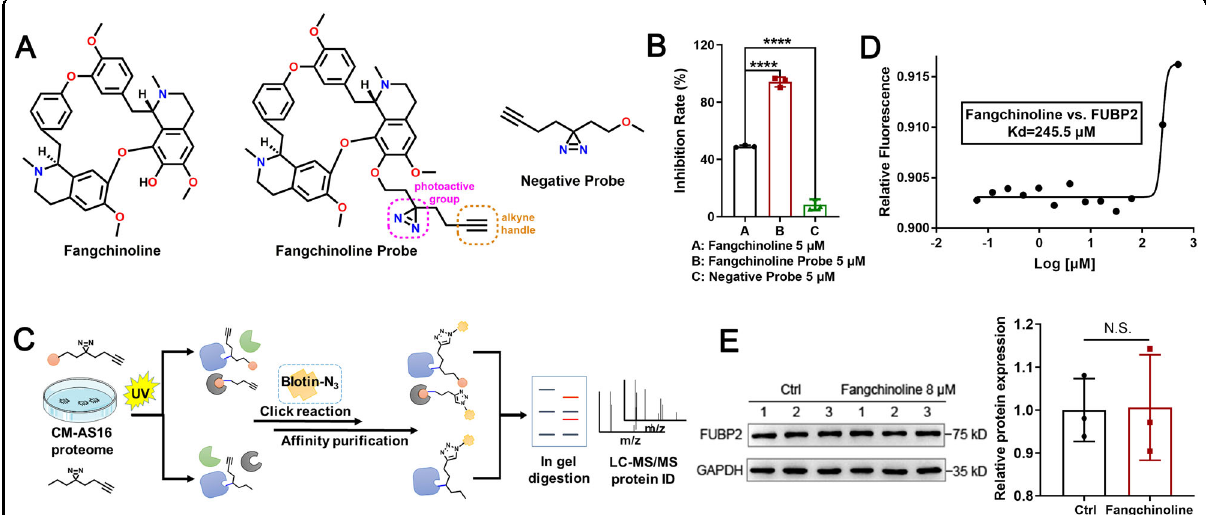
Fig. 3 Target search and veri fi cation of fangchinoline. A Chemical structures of fangchinoline, the fangchinoline probe and the negative probe. The diazirine photo-cross-linking group is circled in pink, and the alkyne reporter group is circled in orange. B The inhibition rates of fangchinoline, fangchinoline probe and negative probe at a concentration of 5 μ M against CM-AS16 cells. n = 3. C Schematic representation of the ABPP assay used to identify targets of fangchinoline in CM-AS16 cells. The ‘ orange ball ’ represents fangchinoline. D MST analysis of the binding af fi nity between fangchinoline and FUBP2. The measured K d value is shown. E Immunoblotting for FUBP2 (left) and quanti fi cation of its protein abundance (right) in CM-AS16 cells with or without 8 μ M fangchinoline treatment. Data represent the mean ± SD of three independent experiments. * P < 0.05, **** P < 0.0001, by Student ’ s t